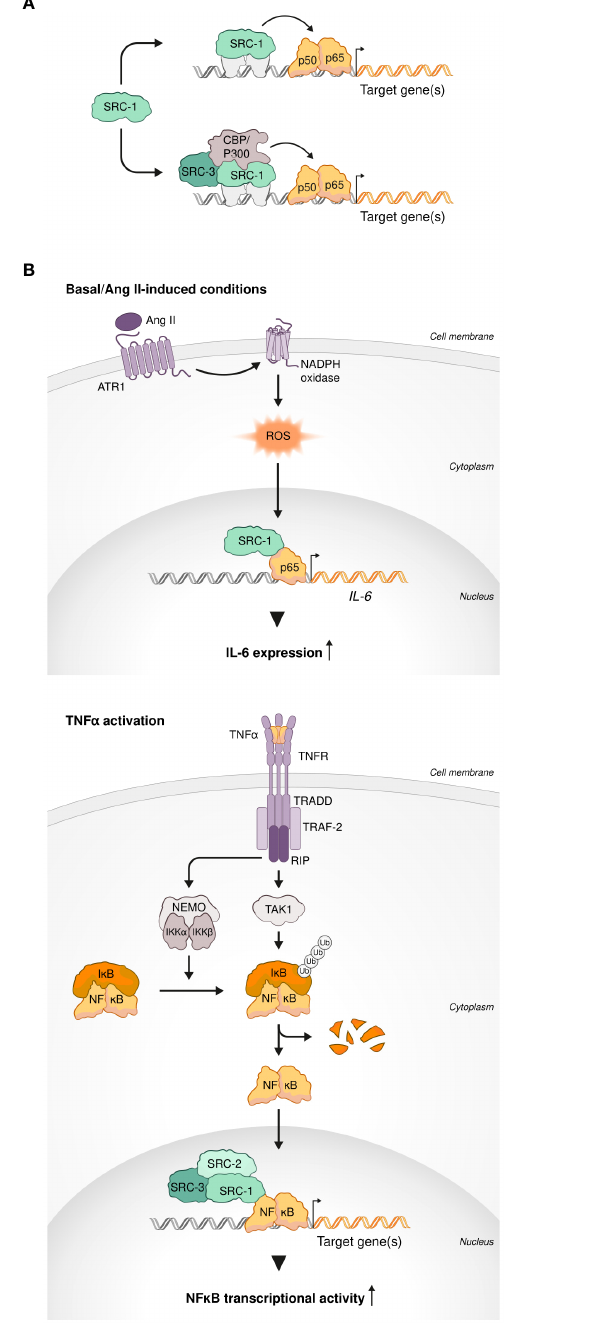
FIGURE 1 SRCs interactions with NF- k b. (A) SRCs are NF- k B coactivators. SRC-1 can coactivate NF- k B transcriptional activity in an independent manner (top). SRC-1 and SRC-3 cooperate with other coactivators (CBP and p300) for synergistic coactivation of NF- k B (bottom). (B) SRCs drive transcriptional activity of NF- k B under in fl ammatory-like conditions. SRC-1 interacts with p65 to induce IL-6 transcription under basal and angiotensin II (Ang II)-induced conditions (top). Under TNF a activation, each member of the SRC family (SRC-1, SRC-2 and SRC-3) can drive NF- k B transcriptional activity